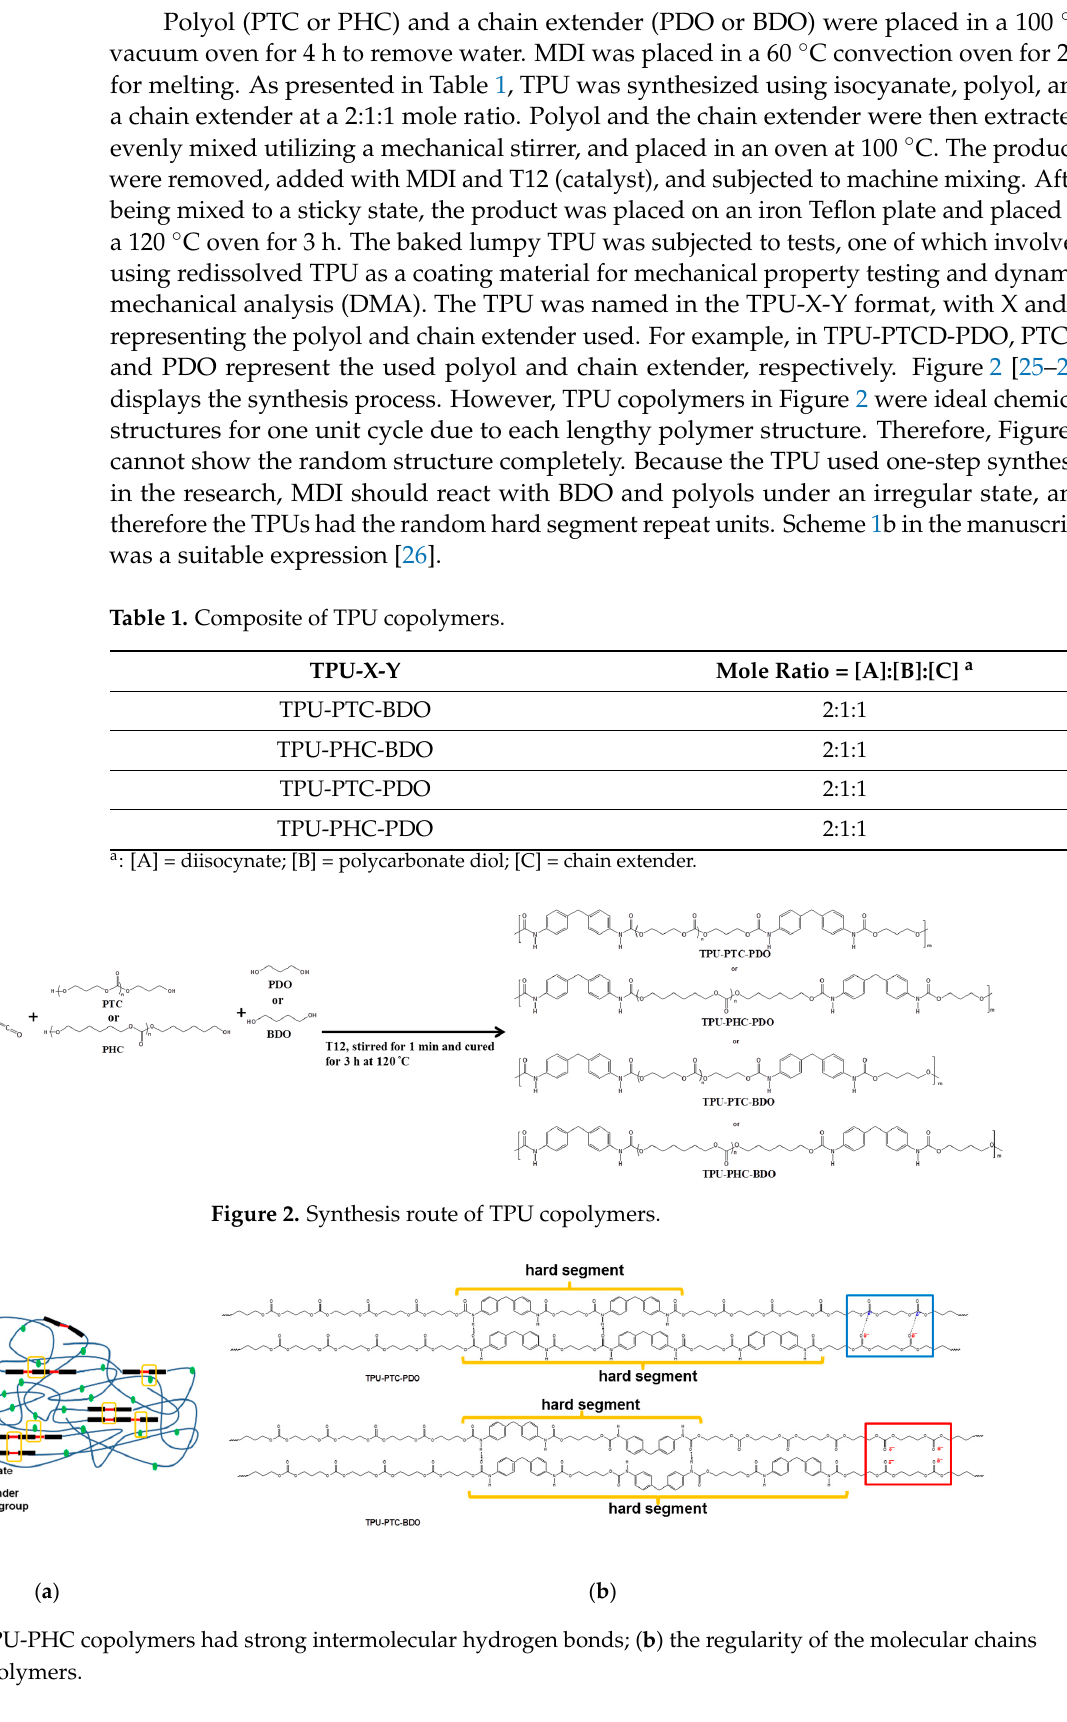
( a ) ( b ) Figure 9. Stress–strain curve of TPU when the chain extender is ( a ) PDO or ( b ) BDO. 3.7. Rheology Testing of Complex Viscosity The complex viscosity of the TPU using the PTC polyol was much lower than that of the TPU using PHC (Figure 10). This result is attributed to the considerable reduction in the interaction of the polarity of PTC polyol at high temperatures, and intermolecular at ‐ traction is lost [22,23]. The master curves obtained from time–temperature superposition also revealed the same trend (Figure 11). Remarkably, the storage modulus of the TPU using the PTC polyol plummeted in the high ‐ temperature region (at a lower angular fre ‐ quency). However, the soft segments of the PHC resulted in chain entanglement, with more interactions existing in the hard chain segments, which were extremely attractive. Therefore, it can reliably support the main structure and maintain the melt strength at high temperatures; for this reason, it will be slightly challenging to process and require higher processing temperatures. However, the urethane group is prone to decomposition under a long ‐ term high ‐ temperature environment. Thus, attention should be paid to the processing time of TPU ‐ PHC samples. Furthermore, the viscosity of TPU ‐ PTC ‐ PDO at 180 °C was slightly lower than that of the TPU ‐ PHC samples at 200 °C. Therefore, the low viscosity of TPU ‐ PTC ‐ PDO facilitates processing. From an energy usage perspective, the suitable processing temperature of TPU ‐ PTC ‐ PDO is lower than that of TPU ‐ PHC sam ‐ ples. Accordingly, the tensile strength of TPU ‐ PTC ‐ PDO was similar to that of the TPU ‐ PHC samples, and it had favorable fluidity at high temperatures. These results indicate that TPU ‐ PTC ‐ PDO can be applied in coating or precision injection, which may expand the future usage of polycarbonate TPU elastomer.